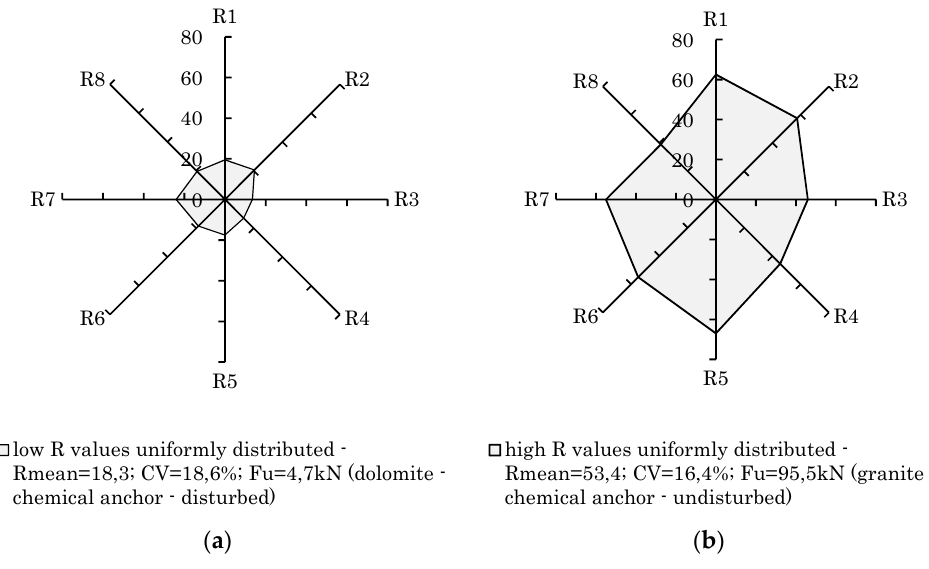
low R values uniformly distributed - chemical anchor - disturbed) Rmean=18,3; CV=18,6%; Fu=4,7kN (dolomite - chemical anchor - disturbed) Figure 11. Uniformly distributed rebound values R (CV, Rmean, F u ). ( a ) uniformly distributed with low R values; ( b ) uniformly distributed with high R values.